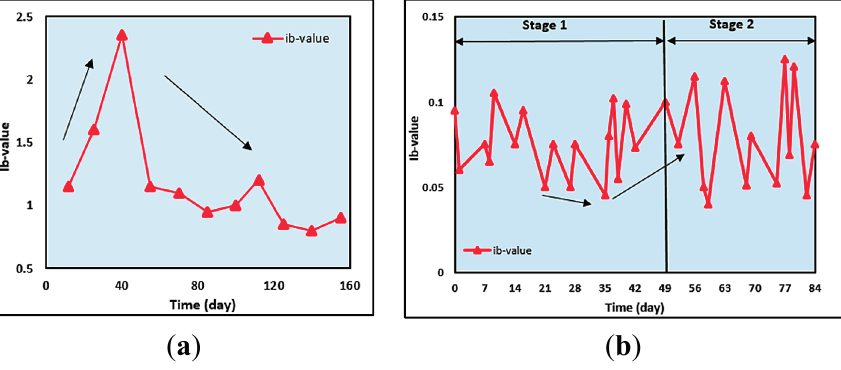
Figure 9. ( a ) b -value analysis (Reproduced and modified from [156]); and ( b ) Ib -value analysis (Reproduced and modified from